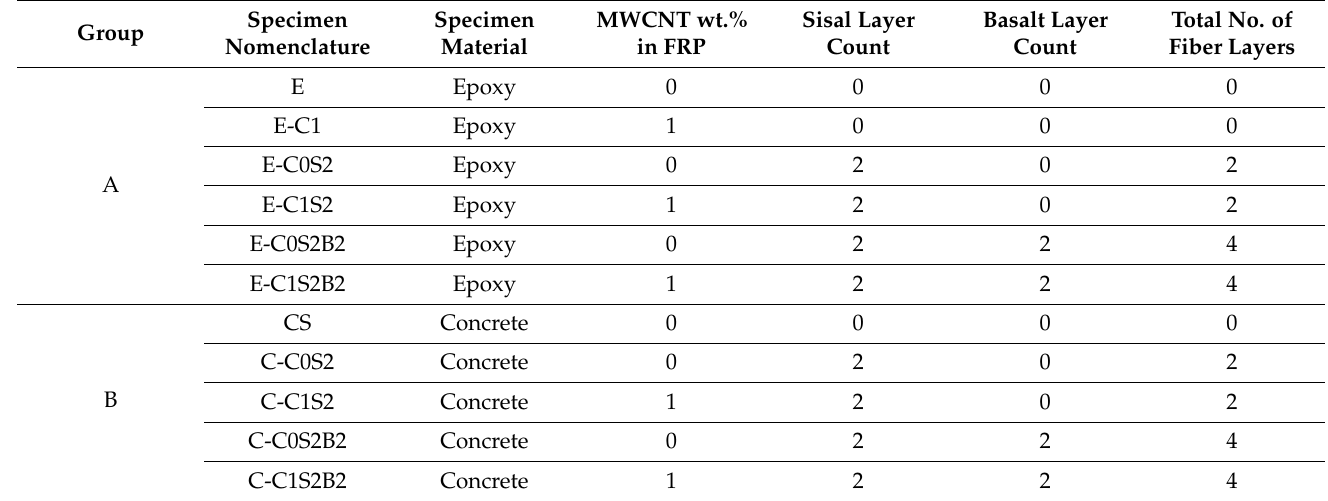
Table 2. Specimen details and